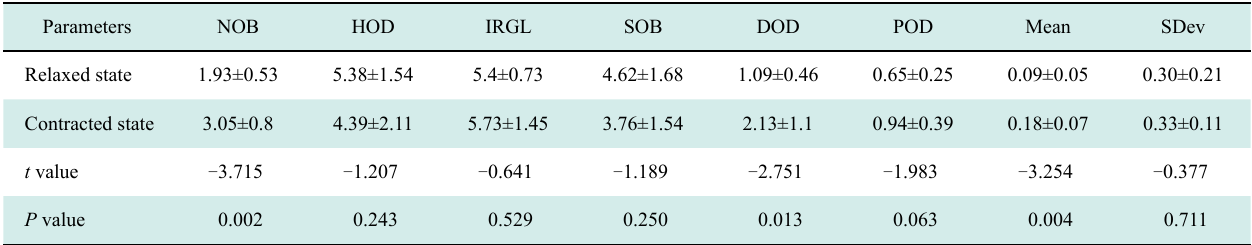
NOB, number of blobs of texture density; HOD, homogeneity of distribution of texture uniformity; IRGL, irregularity of texture primitive shape; SOB, mean size of blobs of texture primitive; DOD, directionality of texture distribution; POD, periodicity of texture distribution; Mean, Mean of texture gray scale; SDev, standard variance of gray scale.